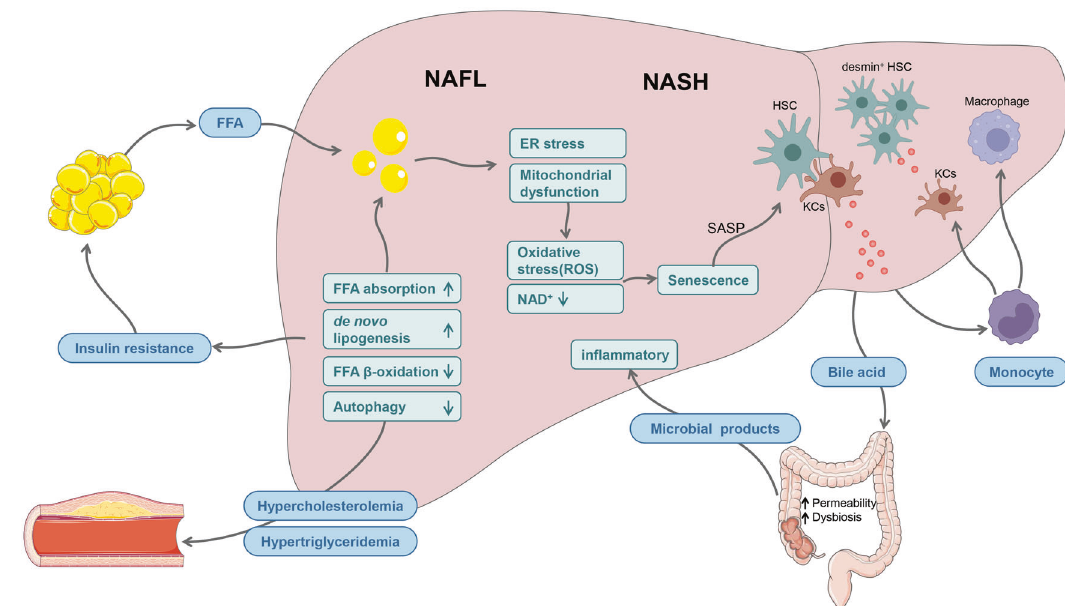
Fig. 4 Crosstalk between aging and NAFLD in aging-related metabolic disease. Aging is related to impaired insulin sensitivity. Under insulin- resistant conditions, the amount of NEFAs in the circulation that are derived from white adipose tissue lipolysis increases, resulting in fat overload in the liver. Aging-related impairment of autophagy and mitochondrial dysfunction reduce hepatic lipid droplet breakdown and fatty acid β -oxidation, respectively. Moreover, under conditions of aging-related obesity, hepatic DNL increases due to ChREBP pathway activation. These disorders of lipid metabolism result in the pathogenesis of NAFL. Following hepatic lipid metabolic impairment and lipid accumulation, lipotoxicity and ER stress are induced, and mitochondrial function further worsens, leading to oxidative stress, hepatocyte apoptosis, hepatocyte senescence and in fl ammation and thus promoting the progression of NASH. Senescent hepatocytes secrete proin fl ammatory cytokines (IL-6, IL-8, TNF- α , and IL-1 β ) that stimulate resident KCs in the liver. Activated KCs present M1-like proin fl ammatory activity and secrete cytokines to induce monocyte in fi ltration into the liver and differentiation into macrophages. Furthermore, impaired resident KCs can induce monocyte differentiation into monocyte-derived KCs to maintain the KC pool in the liver. Both resident KCs and monocyte-derived KCs interact with HSCs and activate HSCs to produce collagen. In addition, dysbiosis of the gut microbiota impairs intestinal permeability; thus, bacteria-derived molecules enter the liver via the portal vein and in turn in fl uence hepatic metabolism and the progression of NAFLD. However, hepatic metabolic impairment and in fl ammation further worsen insulin resistance and dysbiosis of the gut microbiota. Moreover, hepatic lipid metabolic disorder results in hypercholesterolemia and hypertriglyceridemia, leading to accelerated progression of atherosclerosis. (Fig. 4 includes modi fi ed templates from Servier Medical Art (http://www.servier.com), licensed under a Creative Commons Attribution 3.0 Unported